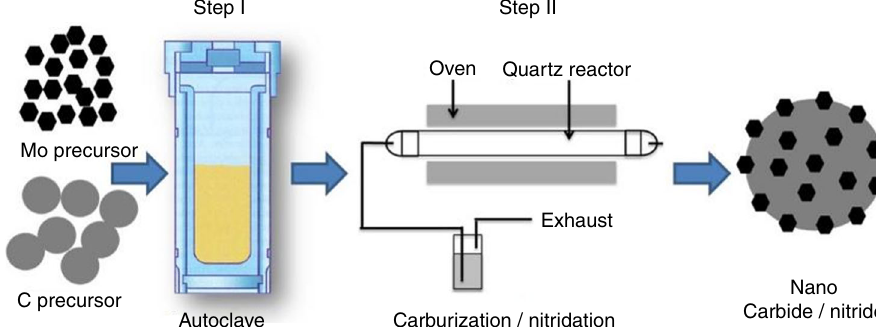
Fig. 1 Schematic of a two-step method for the synthesis of transition metal carbide nanoparticles dispersed on a carbon